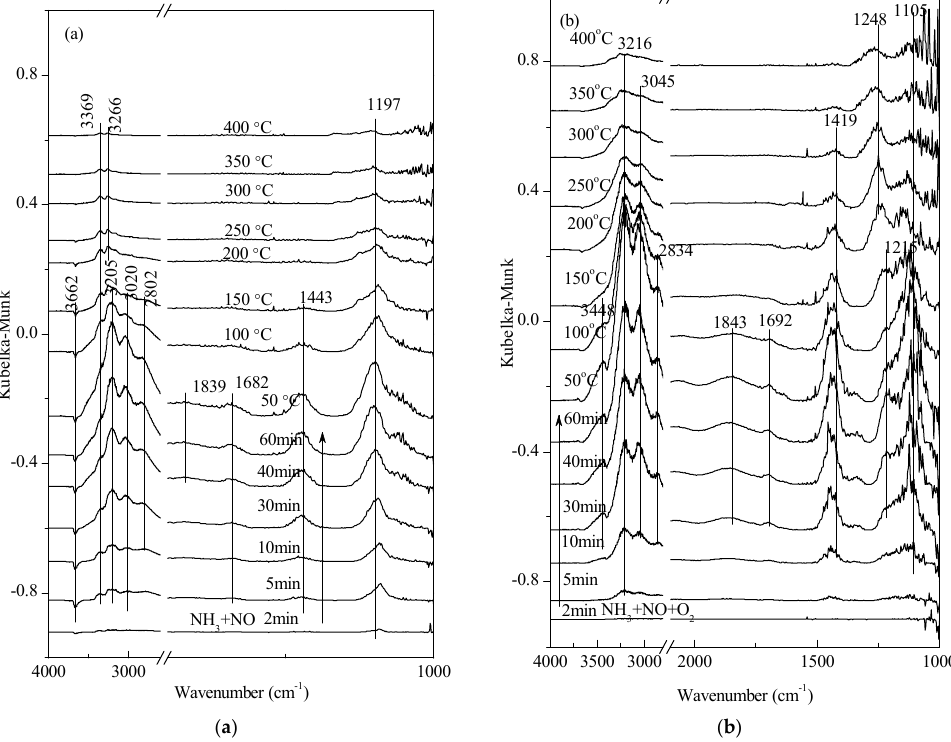
Figure 8. In situ DRIFTS spectra of ( a ) NH 3 + NO desorption and ( b ) NH 3 + NO + O 2 desorption on 1 wt. % V 2 O 5 -0.2CeO 2 /TiO 2 -ZrO 2 as a function of temperature after the catalyst was exposed to a flow of 800 ppm NO, 800 ppm NH 3 , and 5% O 2 for 60 min at 25 °C.